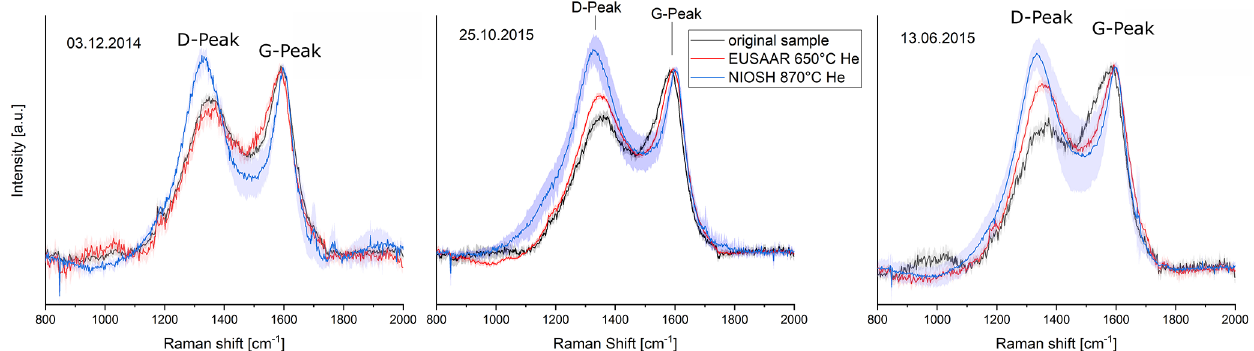
Figure 4. Comparison of Raman spectra of EU650 (red lines) and NI870 (blue lines) for the three samples where D/G of NI870 is larger than D/G of EU650 (from left to right: 3 December 2014, 25 October 2015 and 13 June 2015). Error bars are shown as shaded areas. The D/G ratio increases for NIOSH870 as well as for EUSAAR2 compared to the spectrum of the original sample (black lines), but the relative D -peak of NI870 is visibly higher than the D -peak of EU650 for all three